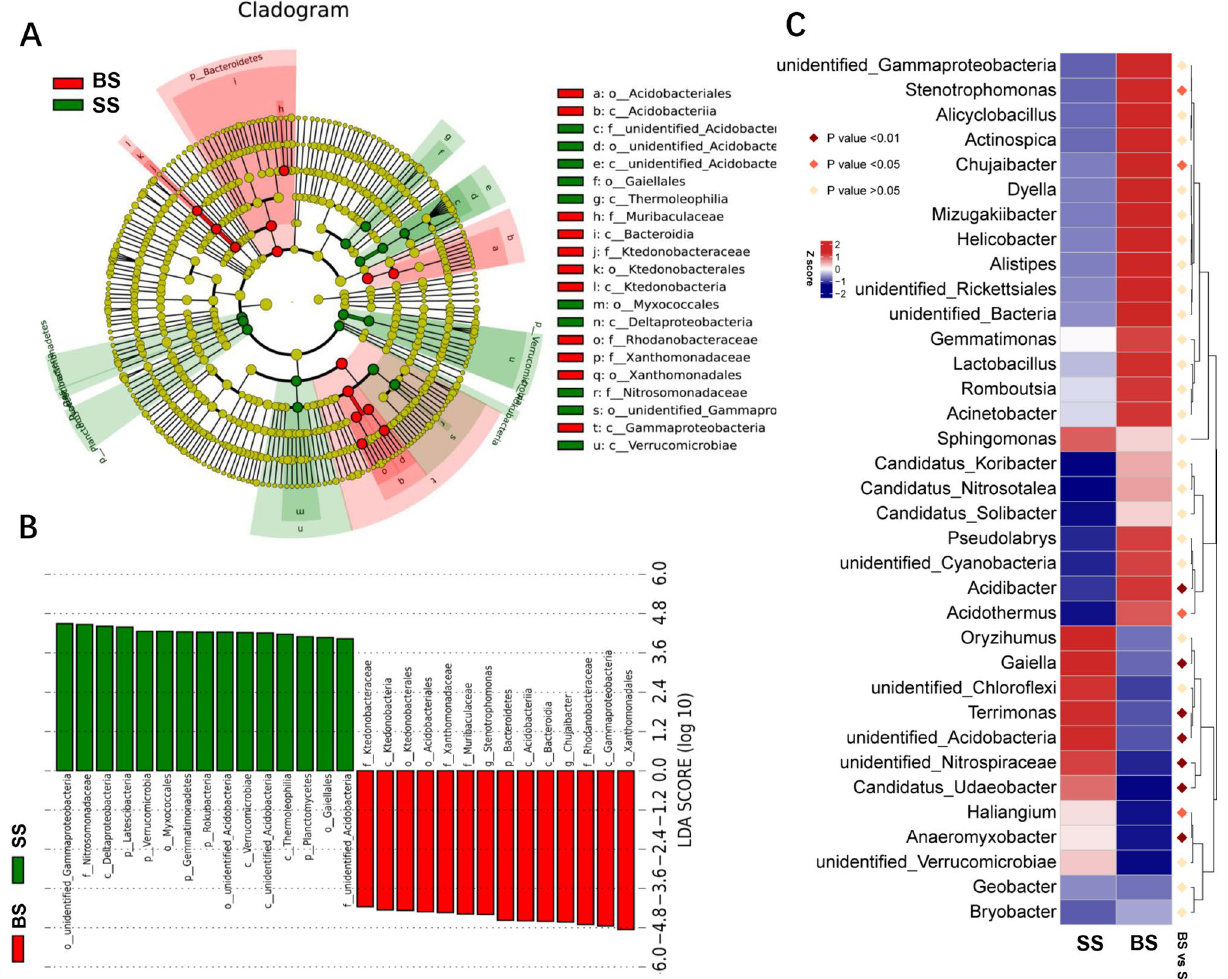
Figure 2. Identification of compositional differences for bacterial species in the BS and SS groups. ( A ) Cladogram indicating the phylogenetic distribution of microbiota correlated with the two groups. ( B ) Linear discriminant analysis (LDA) integrated with effect size (LEfSe), reflecting the differences in abundance between the two groups. ( C ) Heatmap of the relative abundances of the top 30 bacterial genera that differentiate the BS and SS groups. OTUs are shown from lower abundance (in blue) to higher abundance (in red) for the z-transformed data. Data were analyzed by the Wilcoxon rank-sum test (Mann–Whitney U test). Figures were produced using R (v3.4.3, https ://www.R-proje